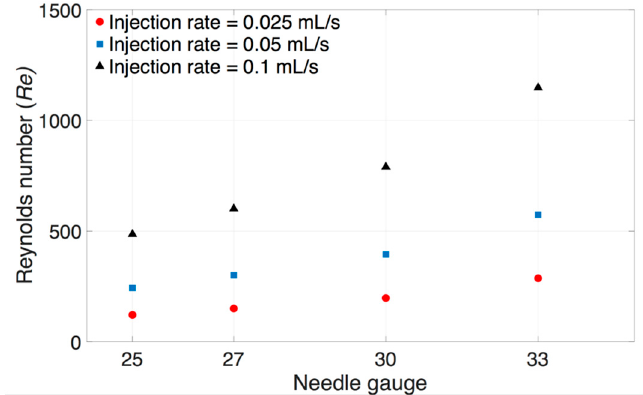
Figure 7. Theoretical changes in Re at different injection rates with varying needle gauges (25 – 33G). Re increased with smaller needle sizes for a fixed flow rate. The Re suggests that the flow pattern of IVT in clinically-relevant needle sizes tends to be